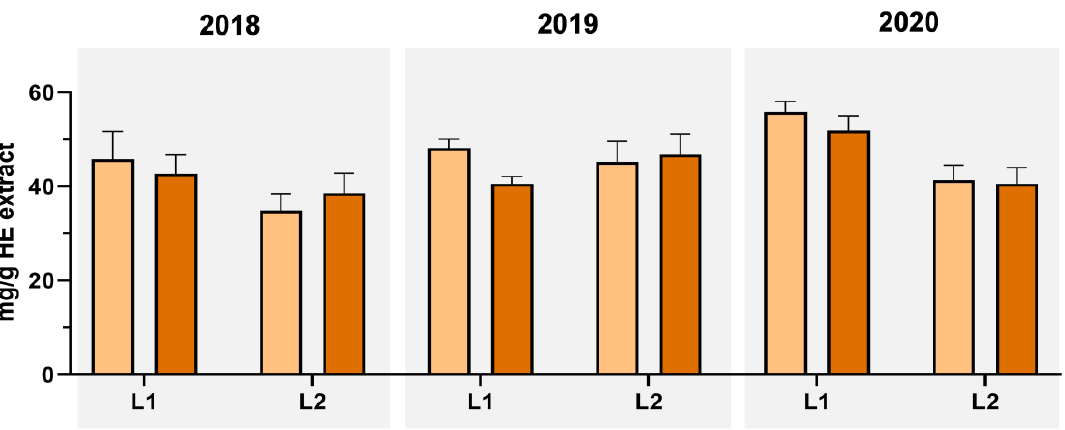
Figure 6. Annual variation (2018–2020 period) of oleanolic (OA) and ursolic (UA) acids in T. carnosus hydroethanolic extracts obtained by HPLC-DAD analysis.